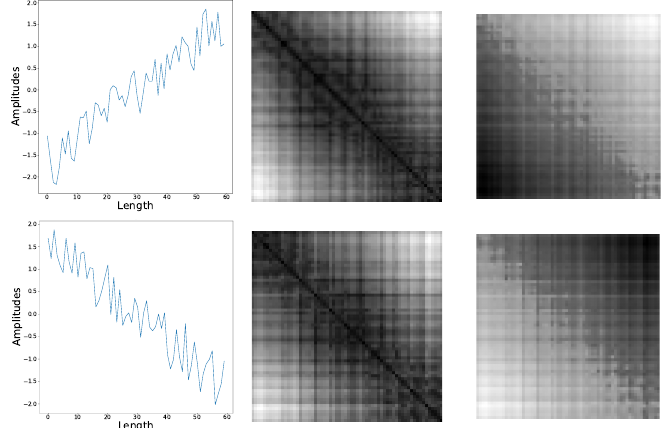
Figure 6. The RP images of sequences with opposite tendencies. (left column: two sequences with opposite tendencies from ’SyntheticControl’ dataset, middle column: the RP images of the sequences, right column: signed RP images of the